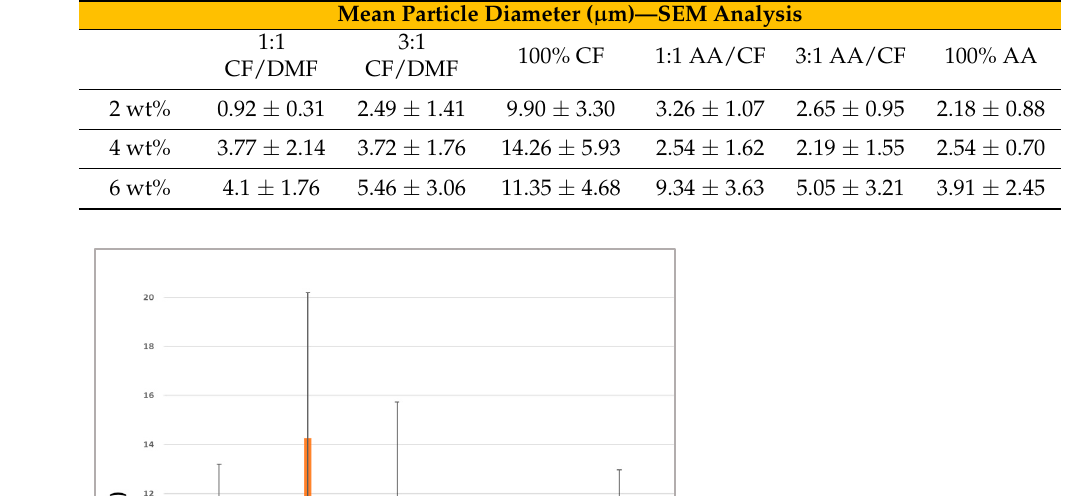
Table 2. Mean diameters of the particles (in µ m) and standard deviations for all combinations of PCL concentration and solvent ratios based on SEM micrographs.